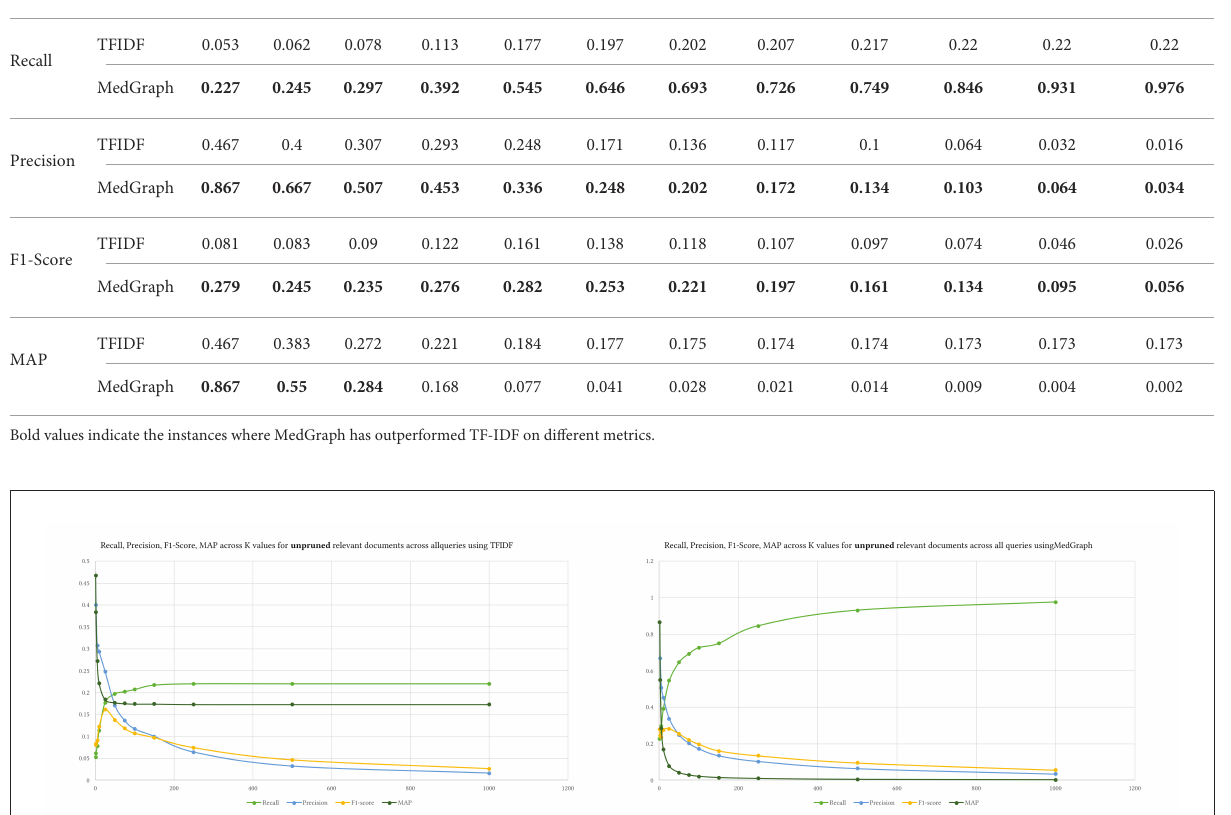
TABLE 4 Results averaged across the 15 queries on different K levels. Metric Method